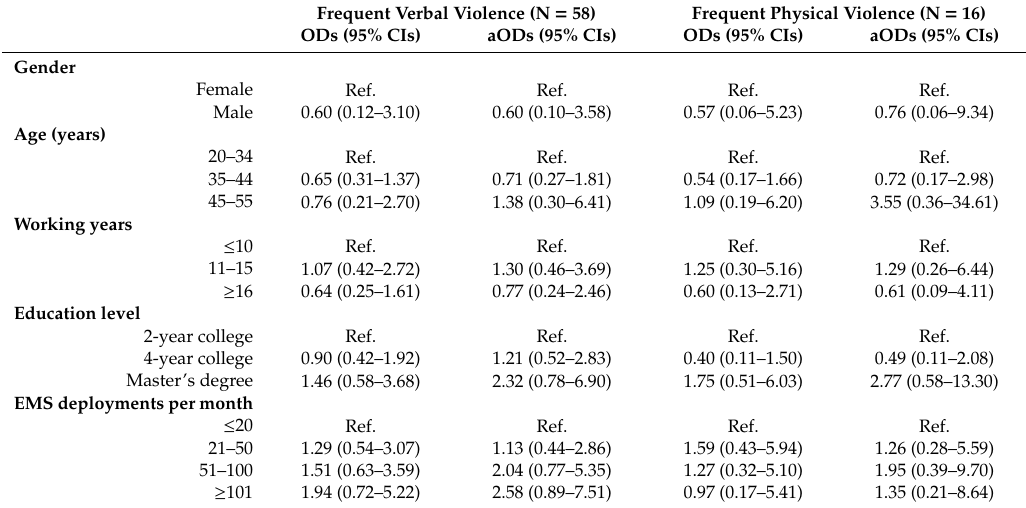
Regression analysis of risks for frequent (at least once every 3 months) verbal or physical